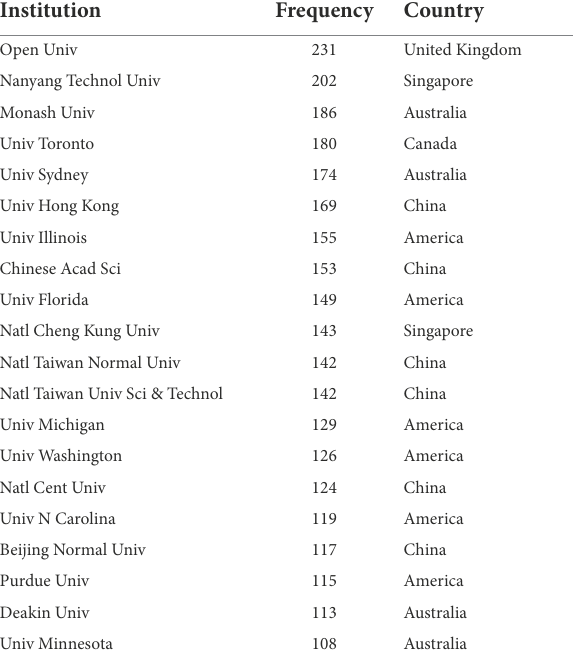
TABLE 3 A list of the top 20 most frequently visited institutions.